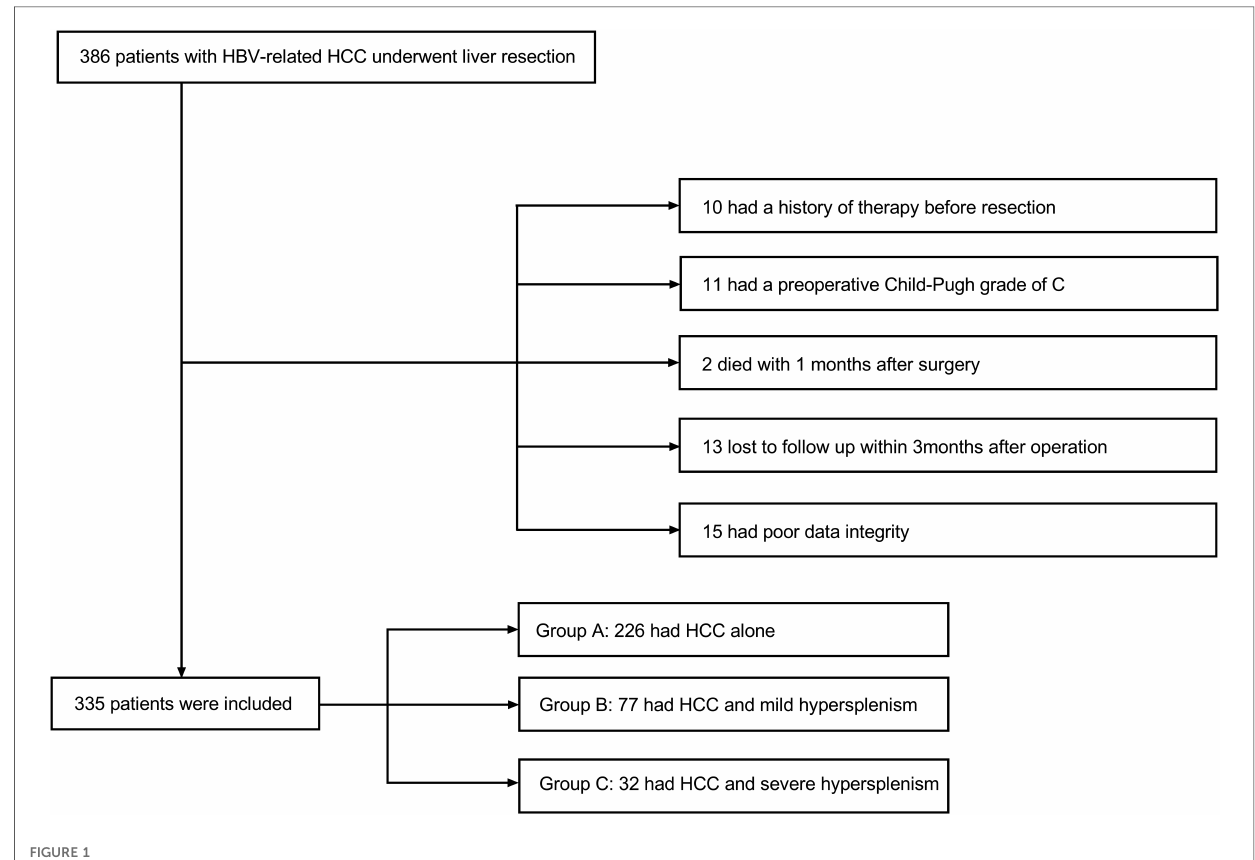
FIGURE 1 Flowchart of the selection process of study participants for the present